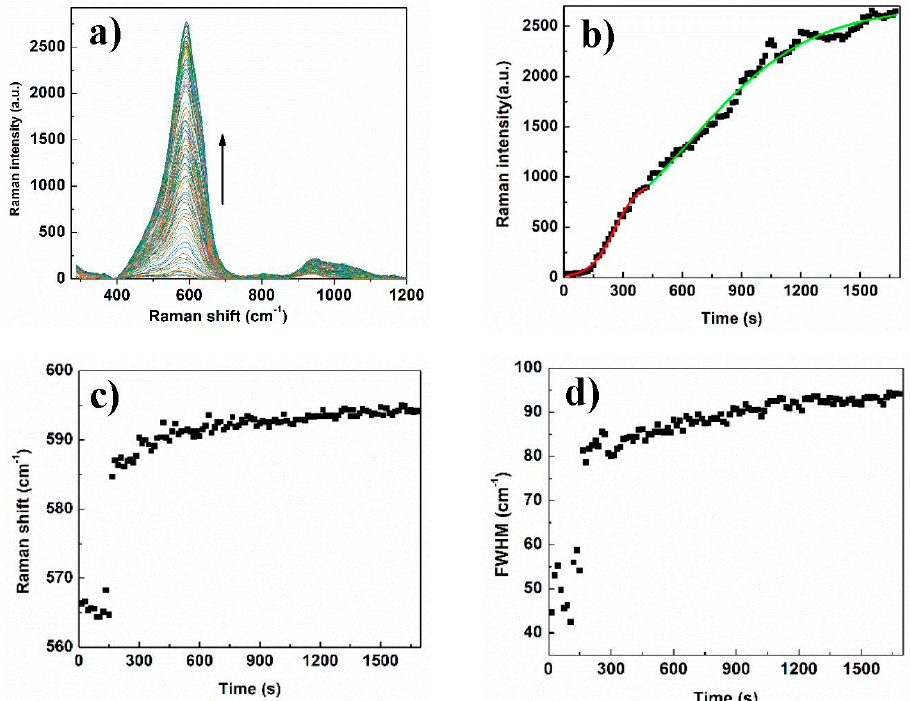
Figure 5. ( a ) Time-dependent Raman spectrum of Cr (III) + EDTA in presence of Cit-AgNPs at pH = 3.6 ( b ) plotting and fitting the maximum of Raman intensity versus time by using Prout–Tompkin equation. Between 0 and 400 s, k = 0.98 min − 1 , adj. R-squared 0.99 and between 400 s and 1800 s, k = 0.19 min − 1 , adj. R-squared 0.98. ( c ) Raman shift versus time of Cr (III) + EDTA in presence of Cit-